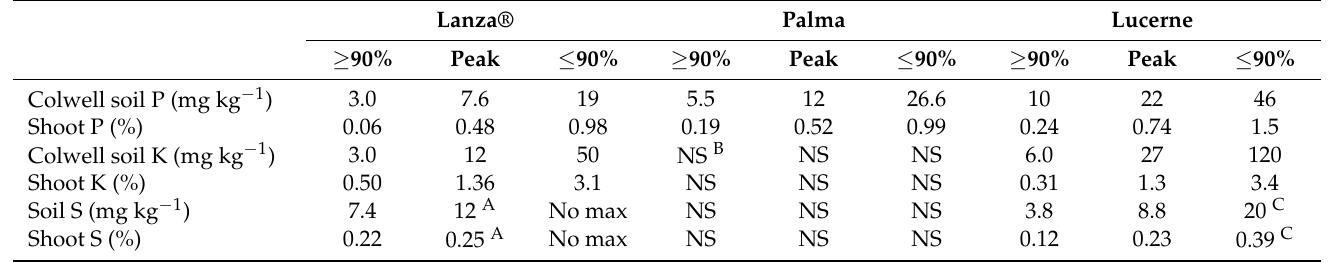
Table 7. P, K and S nutrient concentrations in soils (mg kg − 1 ) and shoots (%) at which two tedera genotypes and lucerne SARDI Grazer production reached and then dropped to 90% of peak biomass based on quadratic models. Measurements outside these figures could indicate deficiency or toxicity.